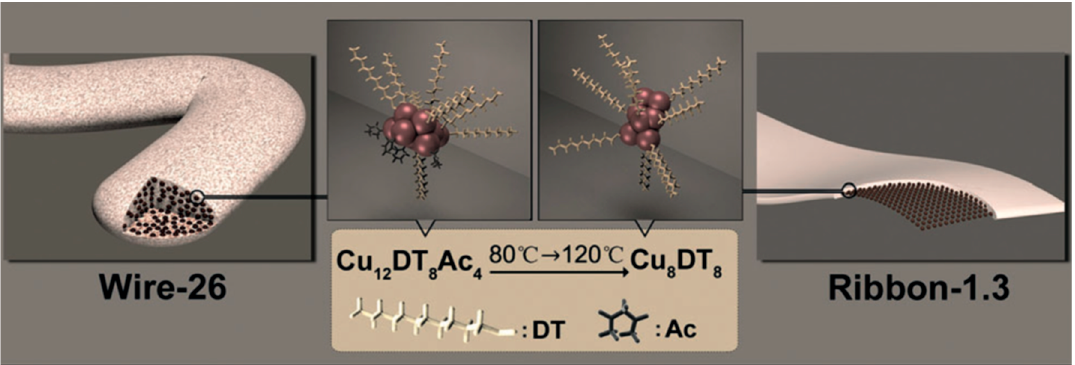
Figure 8. Evolution of Cu NC self-assembly architectures from wire to ribbon. Adapted with permission from Ref. [54]. Copyright (2014) Wiley.